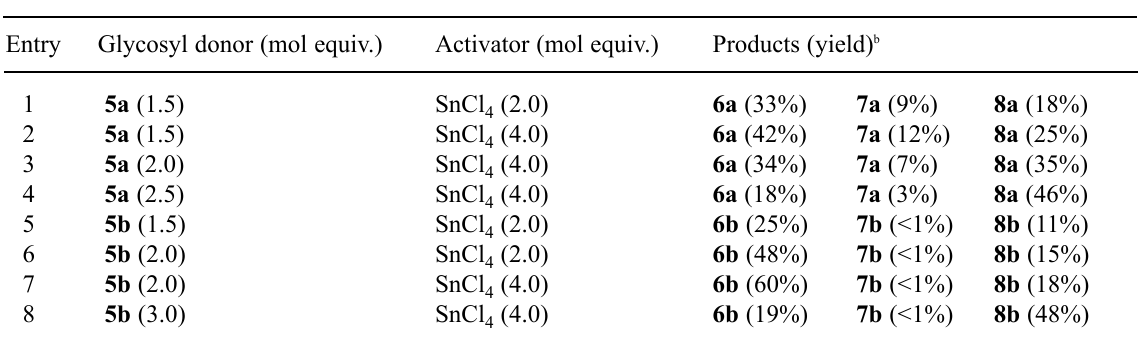
Table 1. Glycosylation of biopterin derivative ( 4 ) a